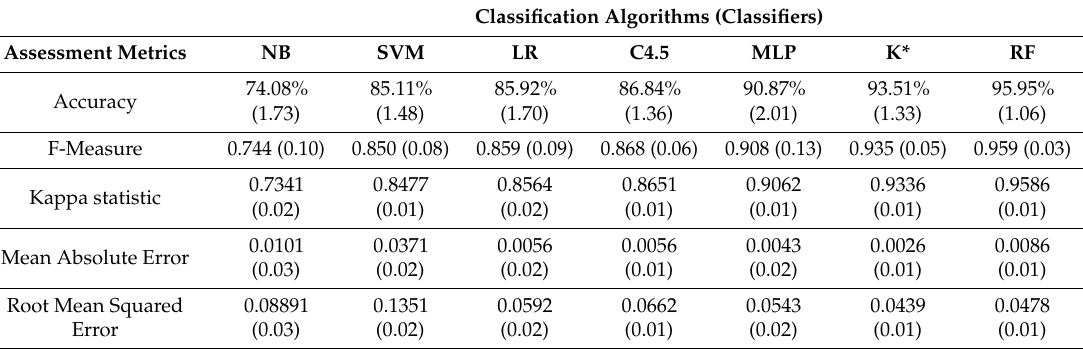
Table 6. Assessment results of